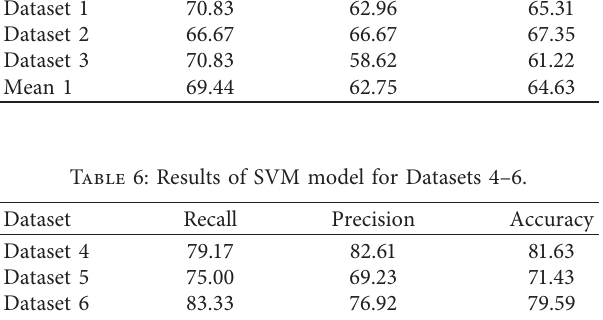
Figure 3: Comparison of judgment results among Dataset 7 and mean